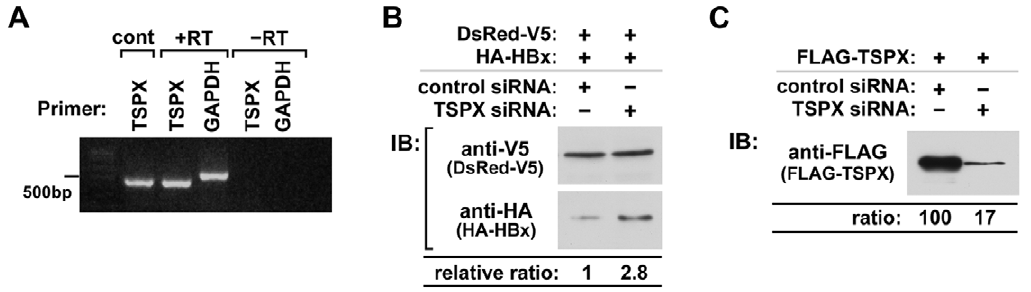
Figure 2. Endogenously expressed TSPX enhances HBx degradation in 293T cells. (A) 293T cells express endogenous TSPX. Total RNA isolated from 293T cells were analyzed by RT-PCR with primer pairs for TSPX[538–693] and GAPDH using a standard technique. Control, PCR product with p3 6 FLAG-TSPX[ D Pro]; + RT, with reverse transcriptase; -RT, without reverse transcriptase. (B) Repression of endogenous TSPX increased the expression of HA-HBx in 293T cells. HA-HBx expression vector (50 ng/well) and DsRed-V5 expression vector (50 ng/well) were co-transfected into 293T cells with either control siRNA (4 pmol/well) or TSPX siRNA (4 pmol/well). Forty-eight hours after transfection, cells were lysed and analyzed by Western-blot using anti-V5 and anti-HA antibodies. Treatment with TSPX siRNA resulted in significant increase in HA-HBx expression (2.8 fold). (C) Effect of TSPX siRNA on TSPX expression. FLAG-TSPX[ D Pro] expression vector (0.1 m g/well) was co-transfected into 293T cells with control siRNA (4 pmol/well) or TSPX siRNA (4 pmol/well). Forty-eight hours after transfection, cells were lysed and analyzed by western-blot using anti-FLAG